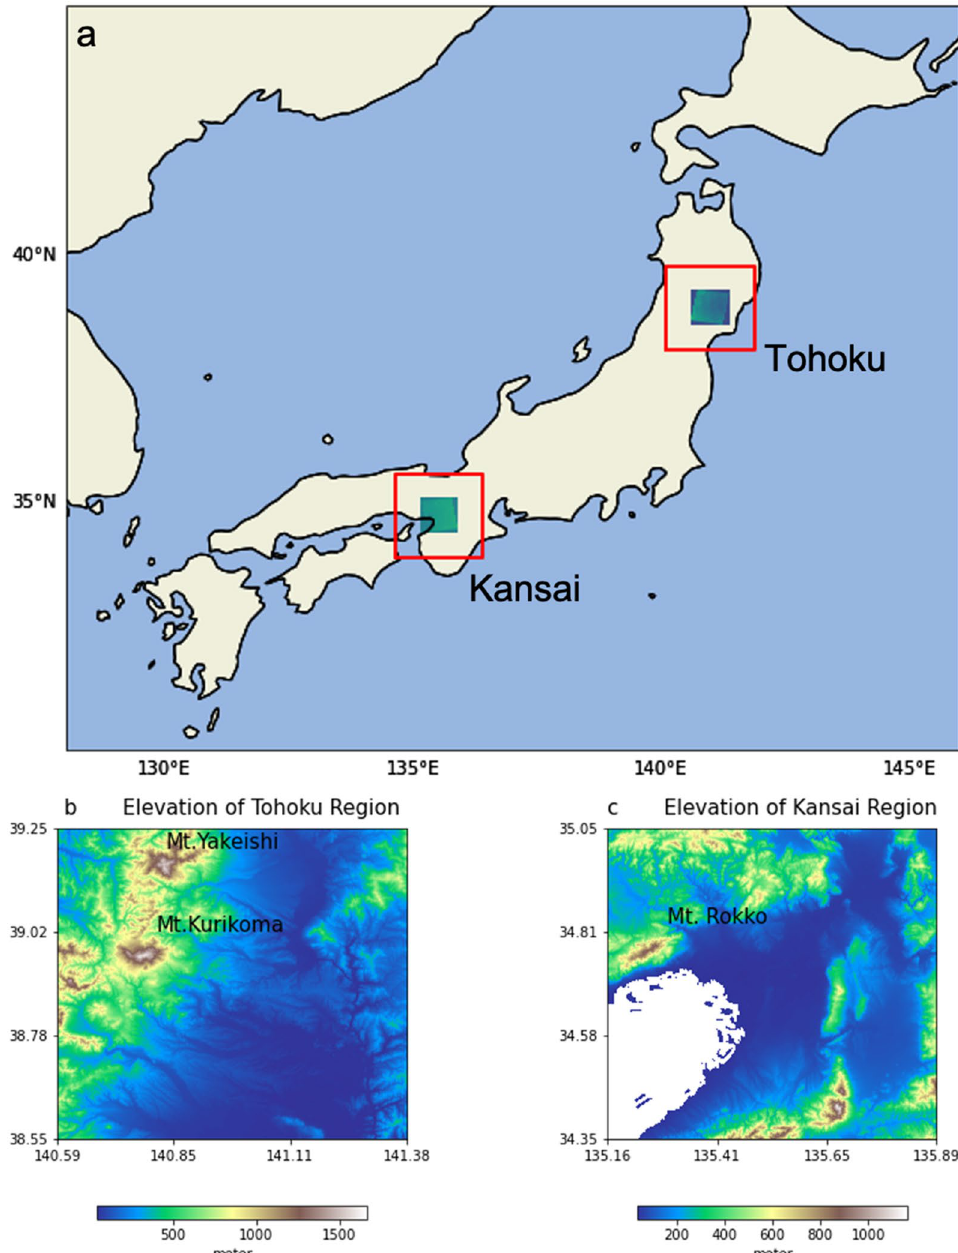
Fig. 2 a Map of Japan with two study areas shown with red rectangles. a , c Elevation maps for the Tohoku and Kansai regions